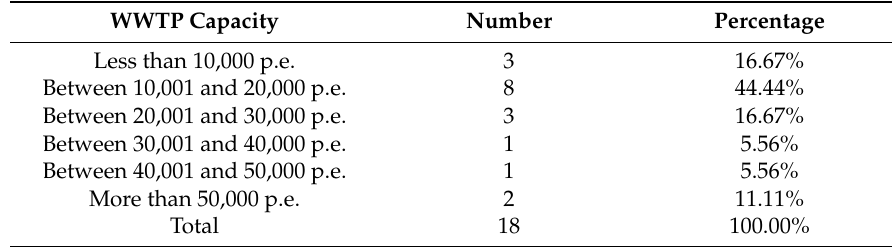
Table 3. WWTP capacity and